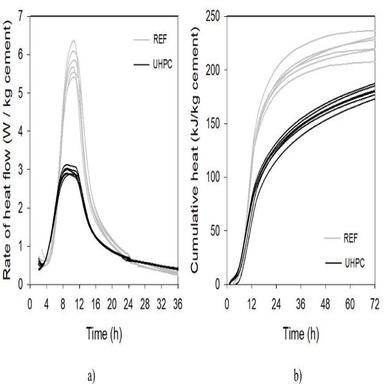
a) Heat of hydration development and b) cumulative heat for REF and UHPC paste samples.